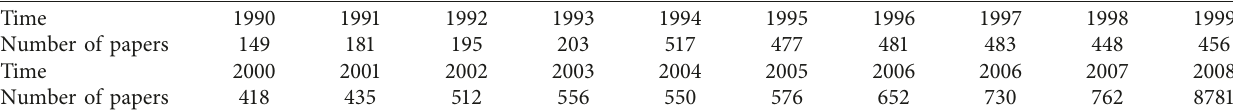
Table 8: The search outcomes of “grey systems.”